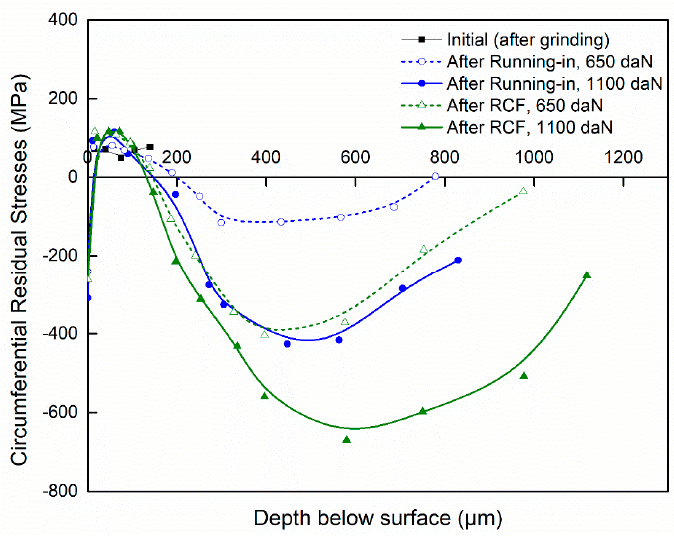
Figure 10. Circumferential residual stresses after different phases.